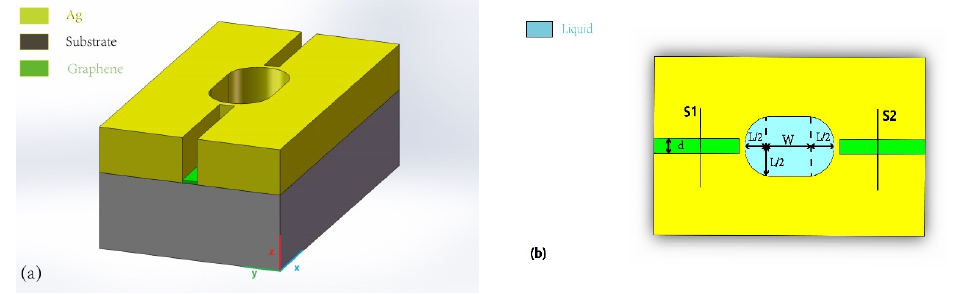
Figure 1. Proposed structure of the racetrack plasmonic resonator sensor. ( a ) 3D schematic diagram of the proposed resonator; ( b ) 2D schematic diagram along x – y